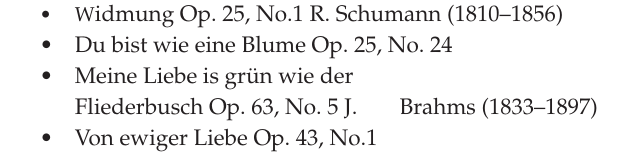
FIGURE 8: Go, Lovely Rose!